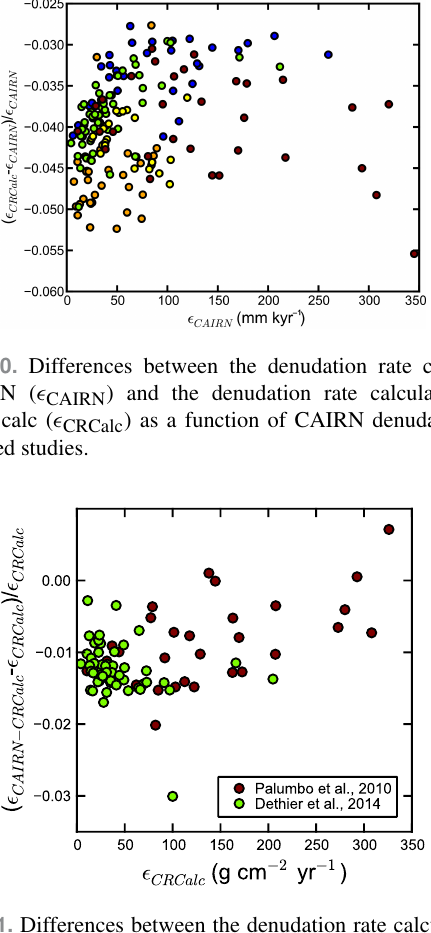
Figure 11. Differences between the denudation rate calculated by CAIRN using the parameters in Table 4 to approximate CRONUS- calc production ( (cid:15) CAIRN-CRCalc ) and the denudation rate calculated with CRONUScalc ( (cid:15) CRCalc ) as a function of CAIRN denudation rate for selected